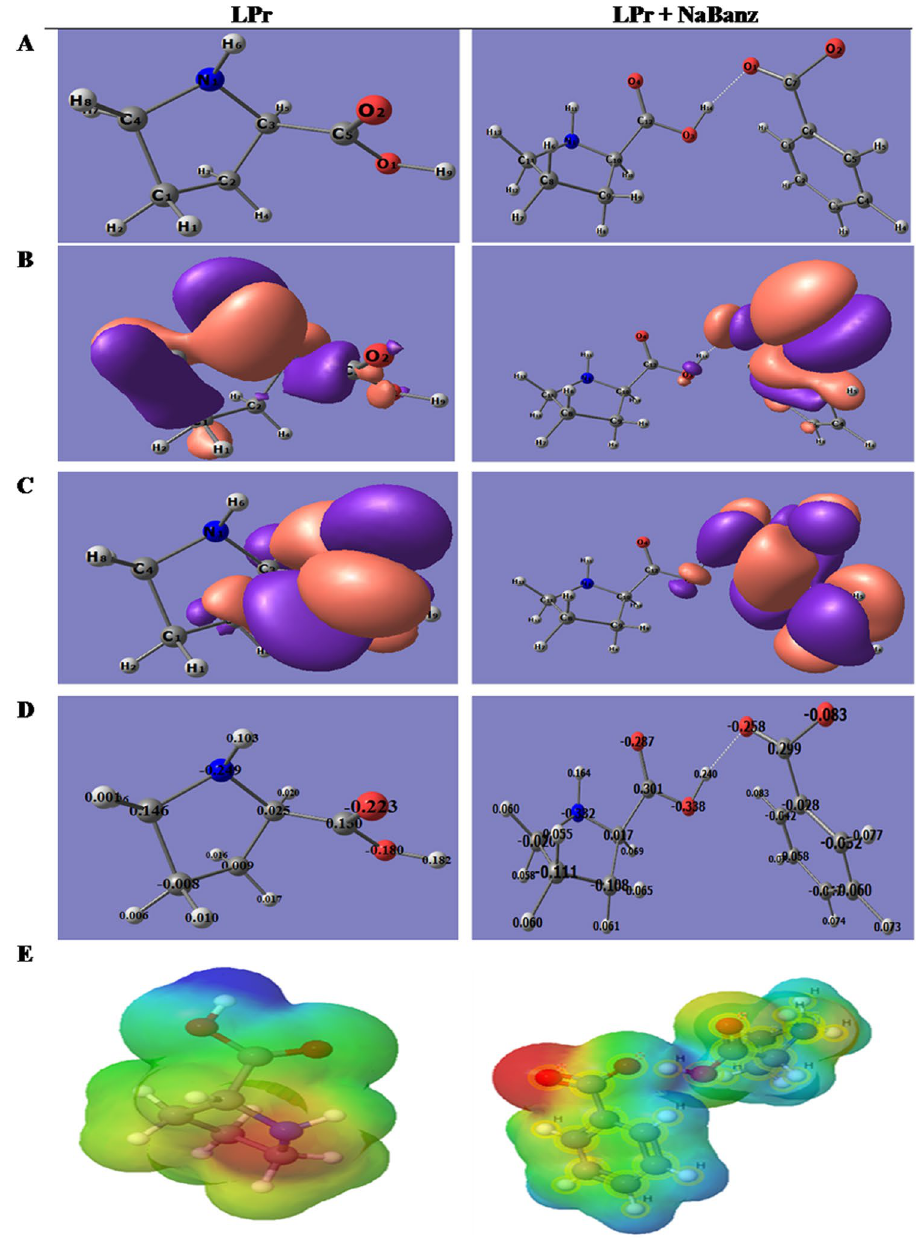
Figure 15. Quantum chemical results of Proline in the absence and prsence of NaBenz calculated by the ORCA programme: ( A ) optimized molecular structure, ( B ) HOMO; ( C ) LUMO ( D ) Mulliken charges ( E ) MEP.